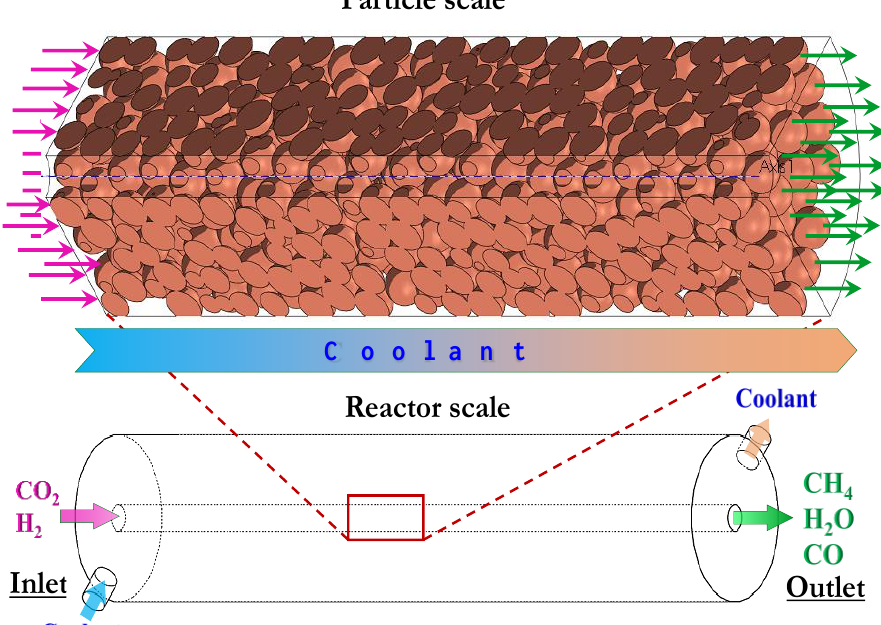
Figure 1. Single tube of an isothermal fixed-bed (IFB) reactor for catalytic CO 2 methanation in the reactor and particle scales.